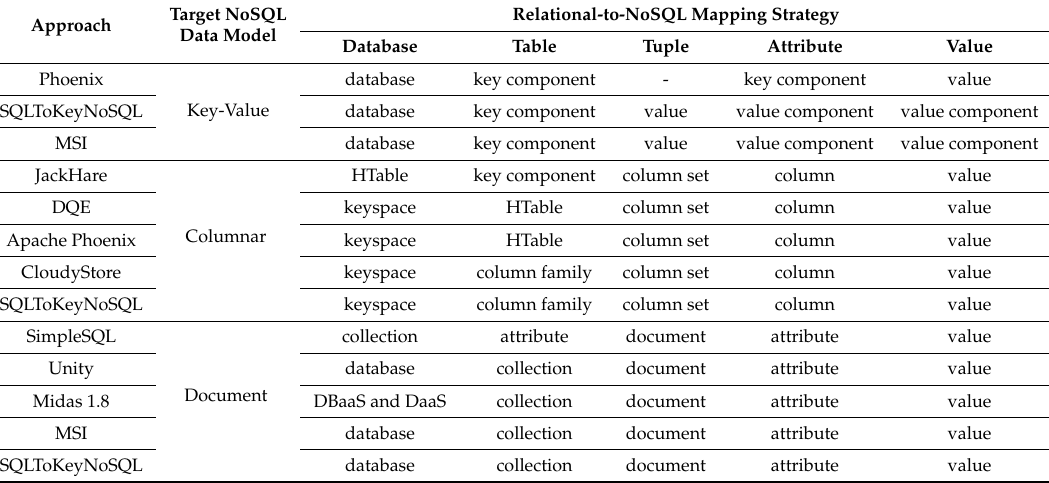
Table 4. Schema mapping strategy